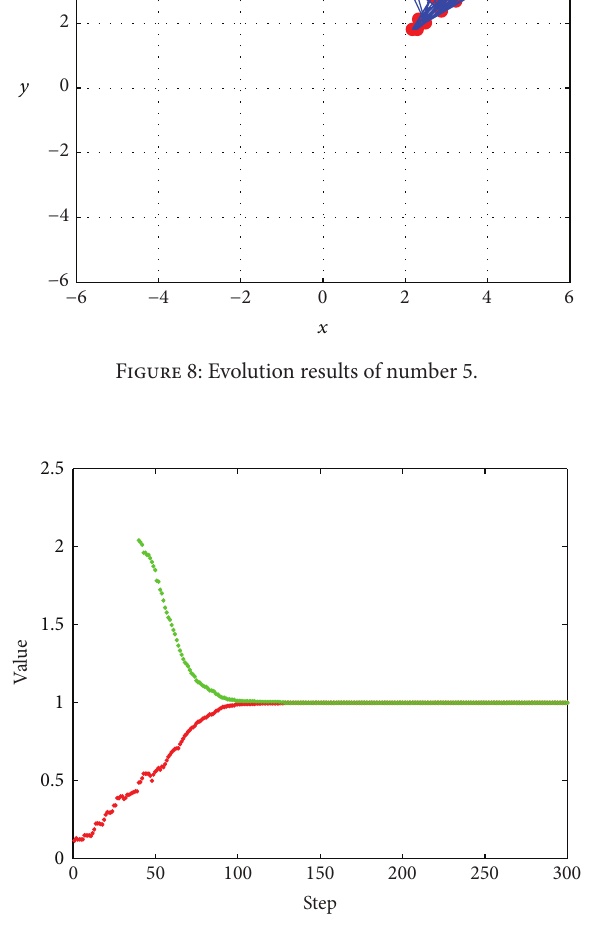
Figure 6: Evolution results of number 3.